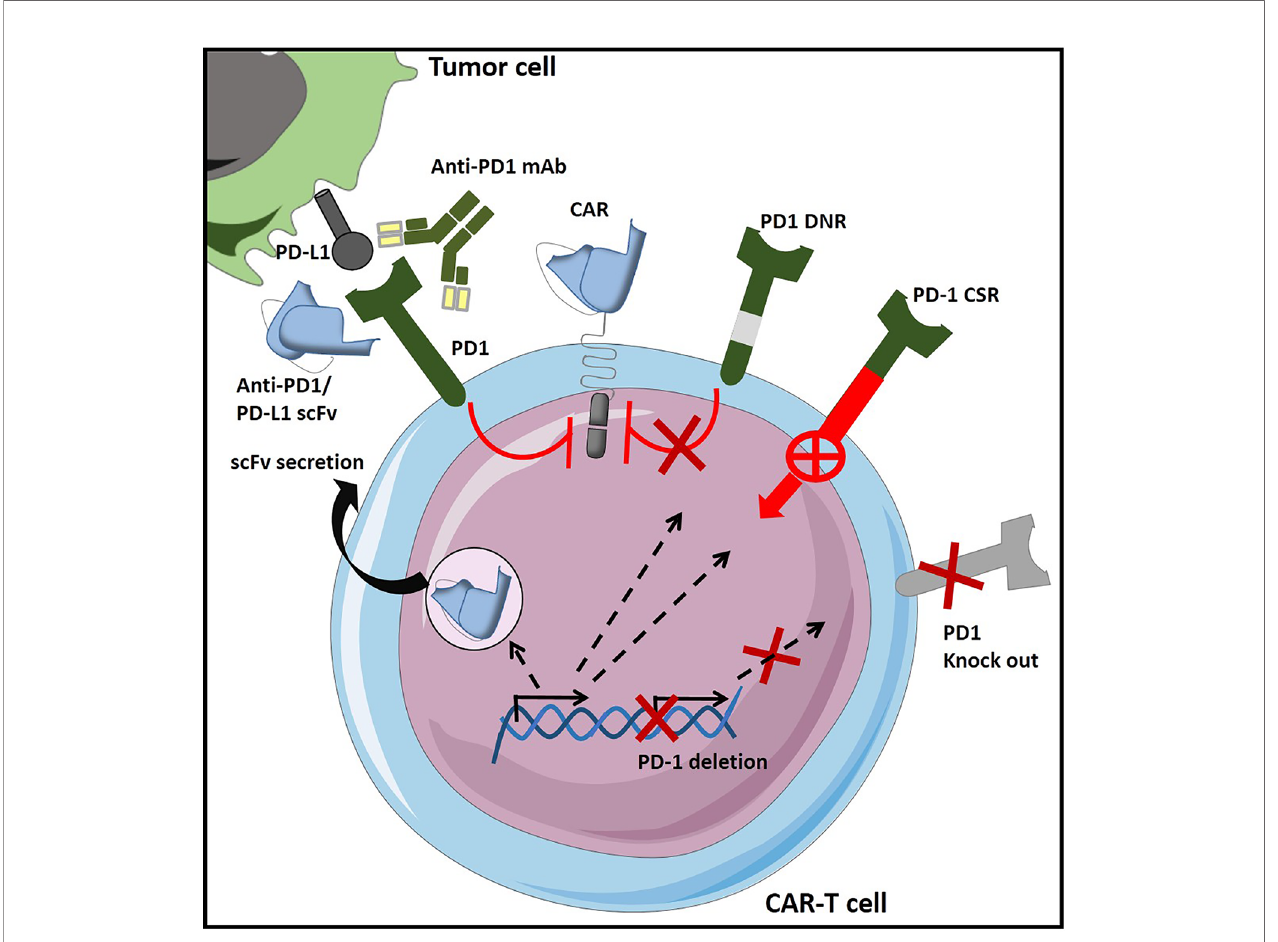
FIGURE 7 | CAR-T cell engineering strategies to overcome inhibition form negative immune checkpoint regulation – Example of PD1/PD-L1 axis targeting in CAR-T cells [Adapted from Ra fi q et al. (31)]. In order to prevent CAR-T cell exhaustion and immunosuppression in the TME, different strategies can be used, like combination of CAR-T cells with immune checkpoint inhibitors (ICIs like anti-PD1 or PD-L1 antibodies). PD1-medited inhibition can also be surmounted by designing CAR-T cells that secrete either PD-1-blocking or PD-L1 blocking scFv. Other means of shielding CAR-T cells from the inhibitory effect of the PD1/PD-L1 interaction is to design genetically modi fi ed CAR-T cells that express a dominant negative PD-1 receptor (PD-1 DNR) which interferes with PD1 downstream signaling or a PD-1 chimeric switch receptor (CSR), which converts an inhibitory signaling into an activating one. Last type of strategy is based on PD1 expression deletion either by genetic knock-out or by means of shRNA (short hairpin RNA)